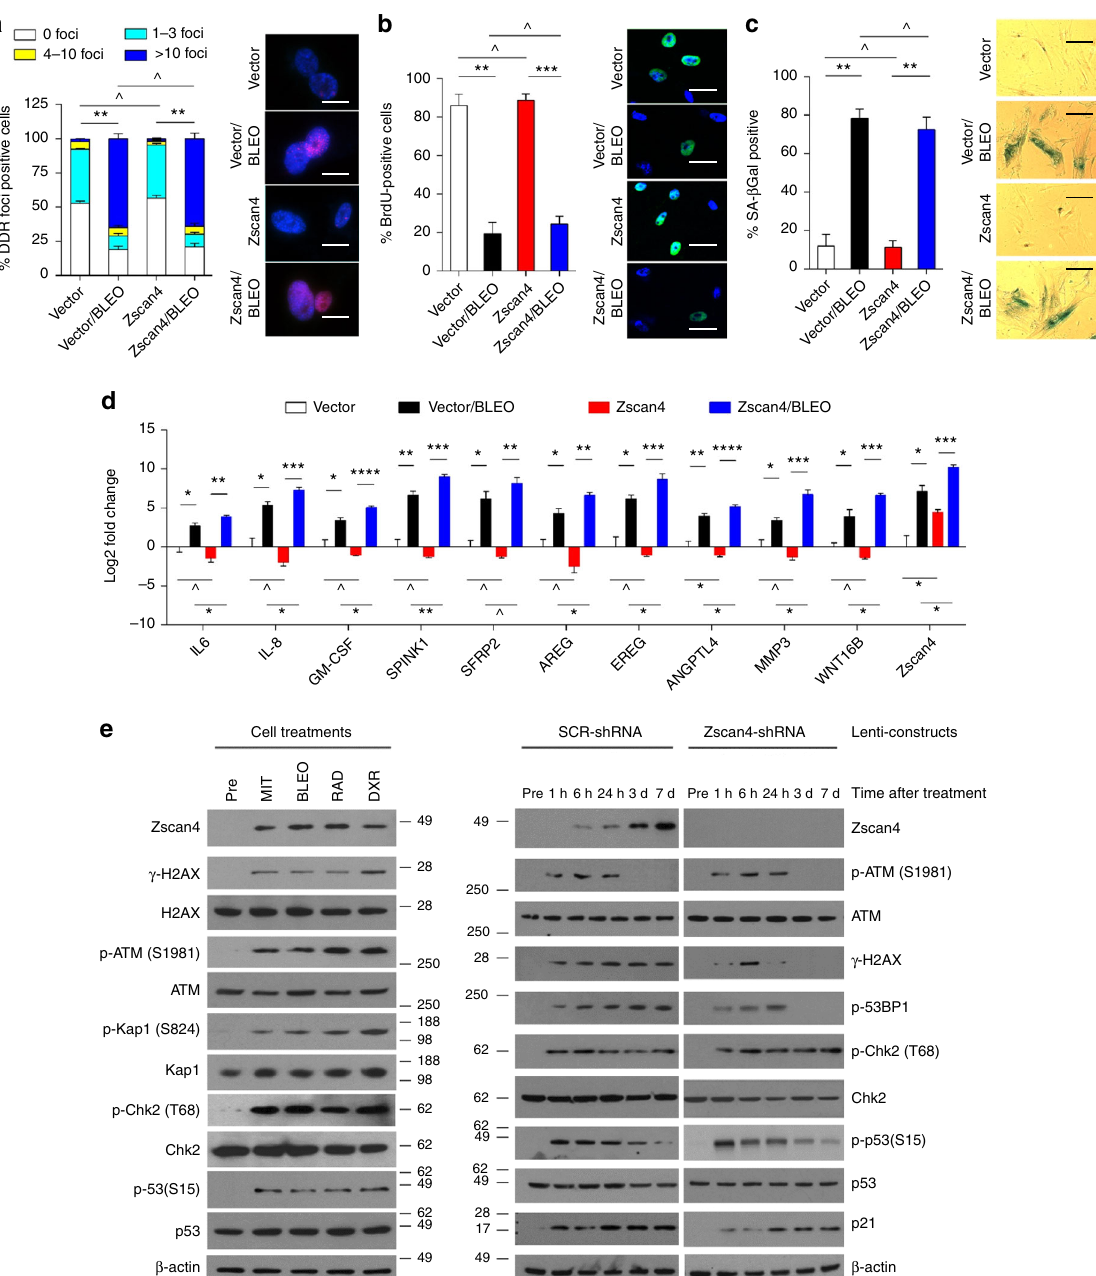
Fig. 3 Zscan4 overexpression does not change stress-induced cell phenotypes but alters SASP expression and DDR signaling. a Statistics of DDR foci in PSC27 stable sublines established via lentiviral infection and treated by bleomycin (50 µ g/ml). The number of cells displaying each category of DDR foci was counted and converted into percentage per cell population. Right, representative images (red, γ H2AX; blue, DAPI). At least 200 cells counted per sample. Scale bars, 10 µ m. Data analyzed by two-way ANOVA. b DNA synthesis evaluation by BrdU incorporation of cell sublines assayed in a , with BrdU- positive cells calculated in percentage. Right, representative images (green, BrdU; blue, DAPI). At least 200 cells counted per sample. Scale bars, 15 µ m. Data analyzed by Student ’ s t -test. c Cellular senescence assessment by SA- β -Gal staining of above cell sublines, with positively stained cells shown in percentage. Right, representative images. At least 200 cells counted per sample. Scale bars, 20 µ m. Data analyzed by Student ’ s t -test. d Transcript expression of canonical SASP factors in stromal sublines treated in a , with values normalized to the vector control per factor. Data analyzed by Student ’ s t - test. e Left, immunoblot analysis of inducible expression of Zscan4 and activation of DDR factors including H2AX, ATM, Kap1, Chk2, and p53 in primary PSC27 cells treated by chemotherapeutic agents. DXR, doxorubicin, a supplementary genotoxic control; Right, cells were lentivirally transduced with scramble-shRNA (SCR-shRNA) or gene-speci fi c shRNA for Zscan4 (Zscan4-shRNA), and treated by bleomycin. Cell lysates were collected at the individual time points post treatment for immunoblotting against Zscan4 expression and DDR factor activation. Data in all bar plots are shown as mean ± SD and representative of 3 representative biological replicates. * P < 0.05, ** P < 0.01, *** P < 0.001, **** P < 0.0001, ^ P >